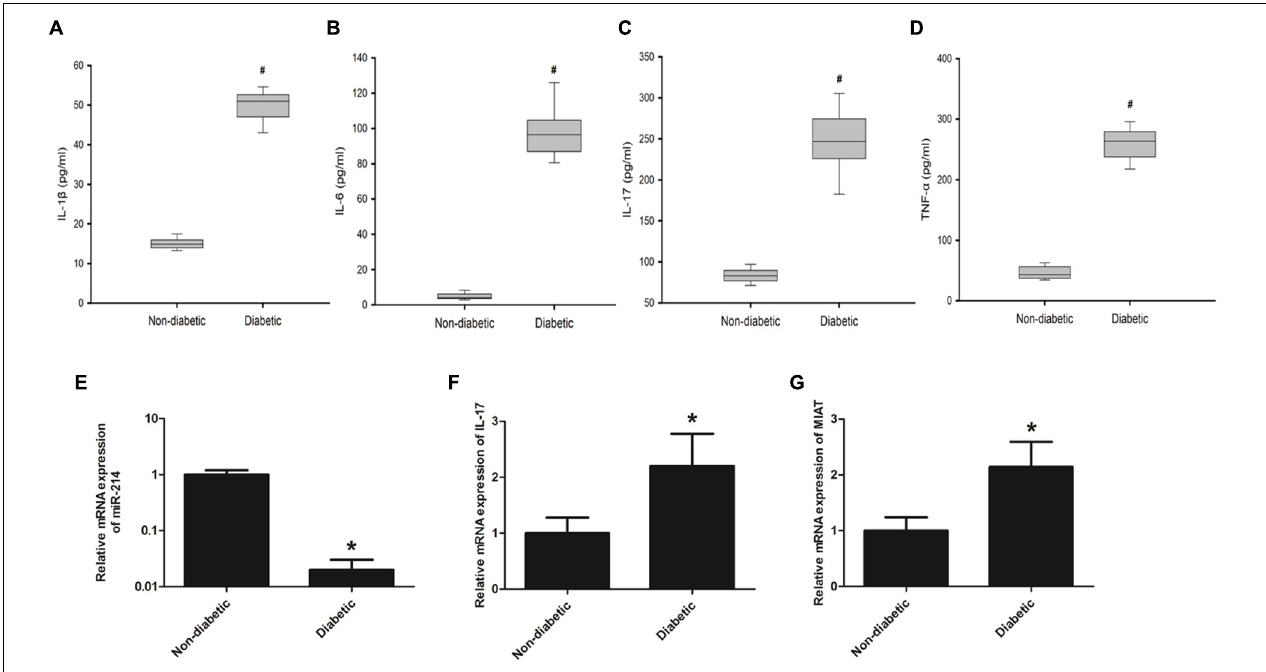
FIGURE 1 | Diabetic patients has elevated expression levels of proinflammatory cytokines as well as lncRNA-MIAT. (A–D) Blood samples collected from diabetic patients or healthy controls were processed for ELISA. Protein expression levels of IL-1 β , IL-6, IL-17, and TNF- α was measured as above-mentioned, * P < 0.05. (E–G) Real-time PCR was performed to analyze the relative mRNA levels of miR-214-3p, IL-17, and lncRNA-MIAT in the serum of either diabetic patients or healthy controls, * p < 0.05, # p <